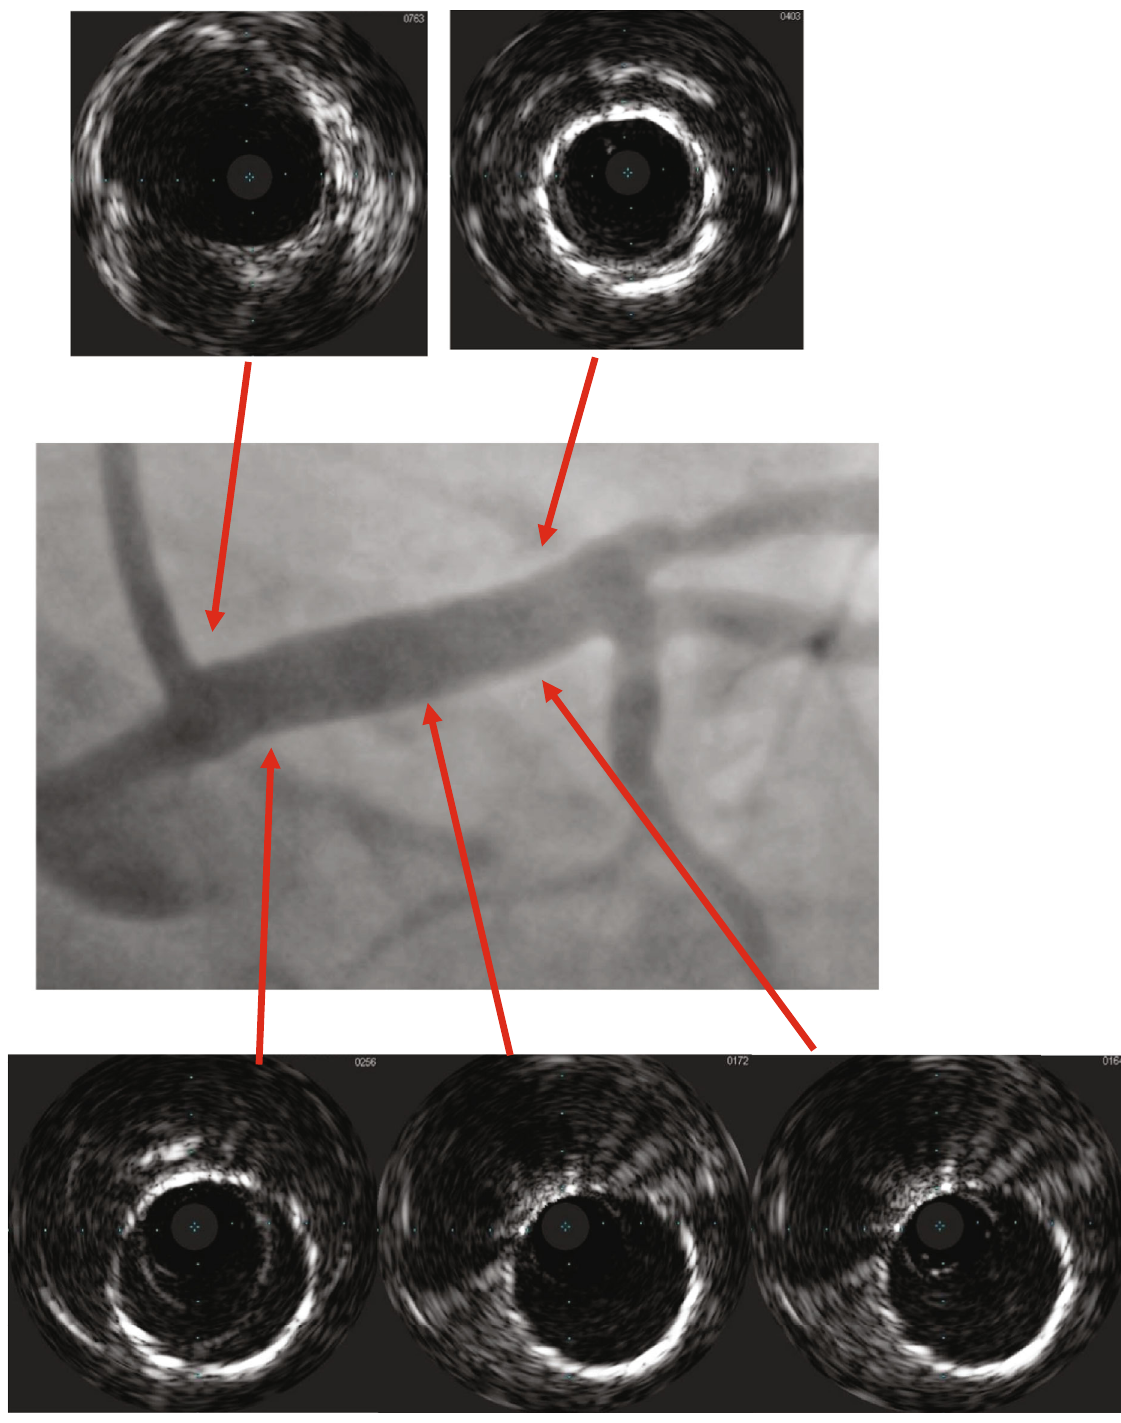
Figure 6: Final IVUS result with single-layer covered stent with diameter of 5mm and complete exclusion of the